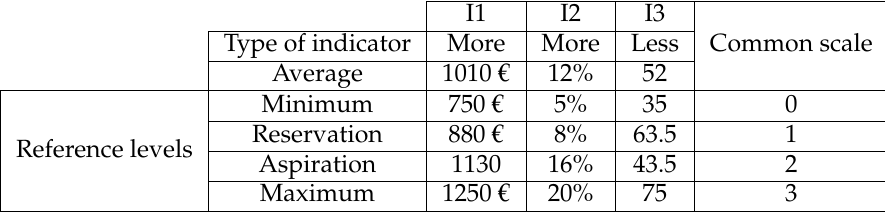
Figure A4. Type of indicators, reference levels and common measurement scale.